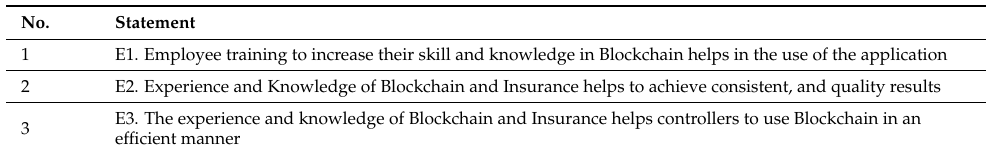
Table 4. List of statements on blockchain experience and knowledge (Source: authors’ compilation).